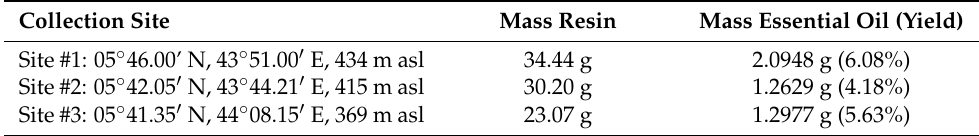
Table 3. Boswellia ogadensis collection and hydrodistillation